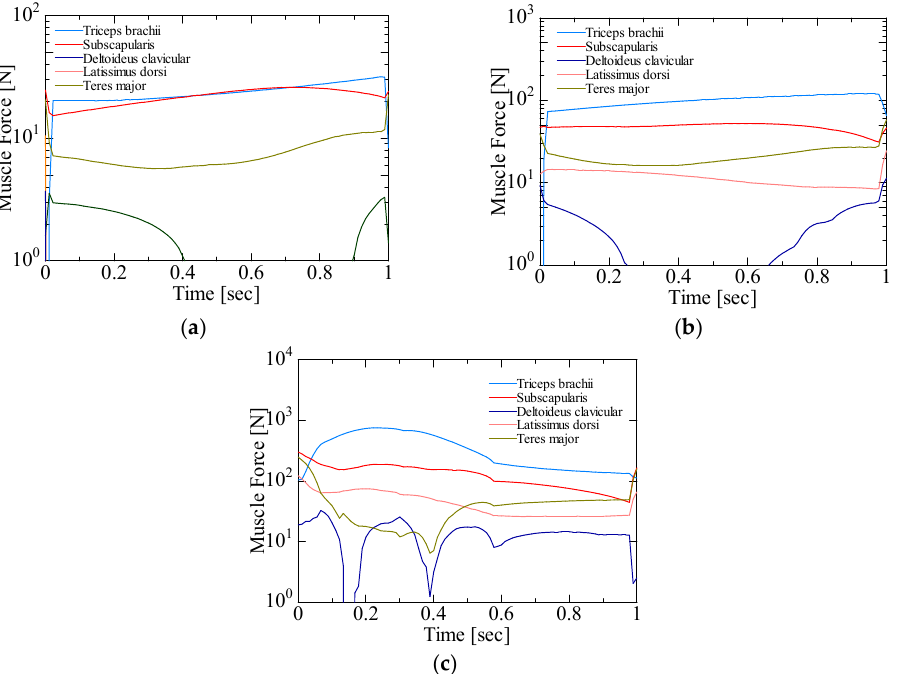
Figure 2. Muscle strength histories in upper arm, ( a ) model A; ( b ) model B; ( c ) model